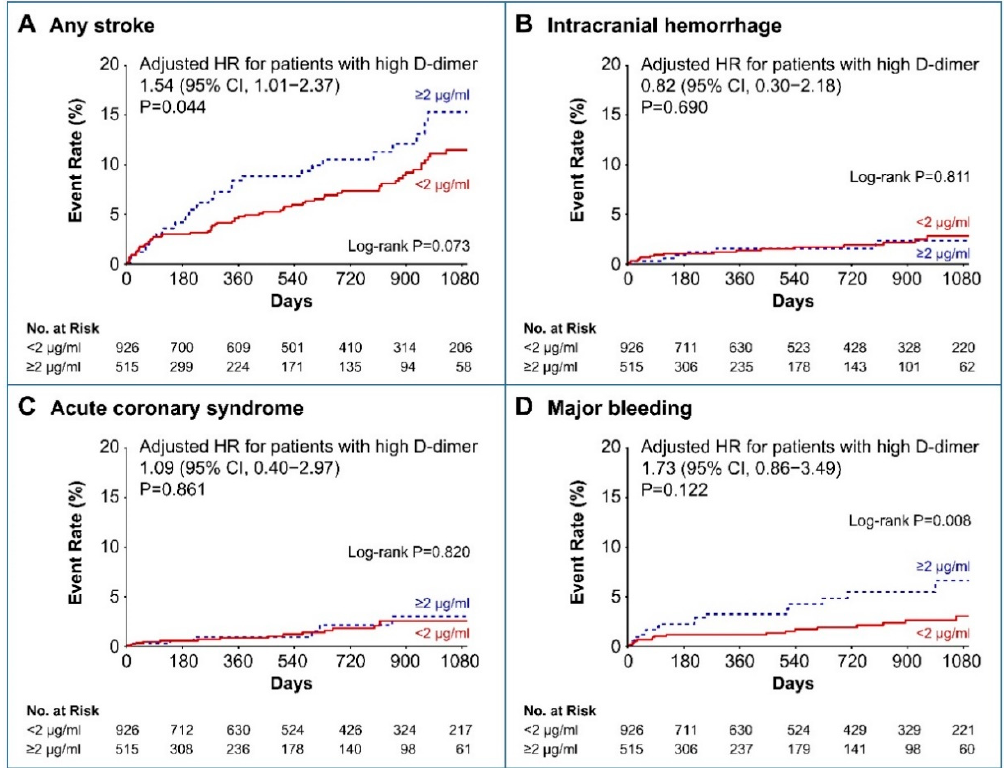
Figure 3. Kaplan–Meier curves and adjusted hazard ratios for secondary outcomes of ( A ) any stroke, ( B ) intracranial hemorrhage, ( C ) acute coronary syndrome, and ( D ) major bleeding according to the baseline D-dimer levels. HR, hazard ratio; CI, confidence interval.